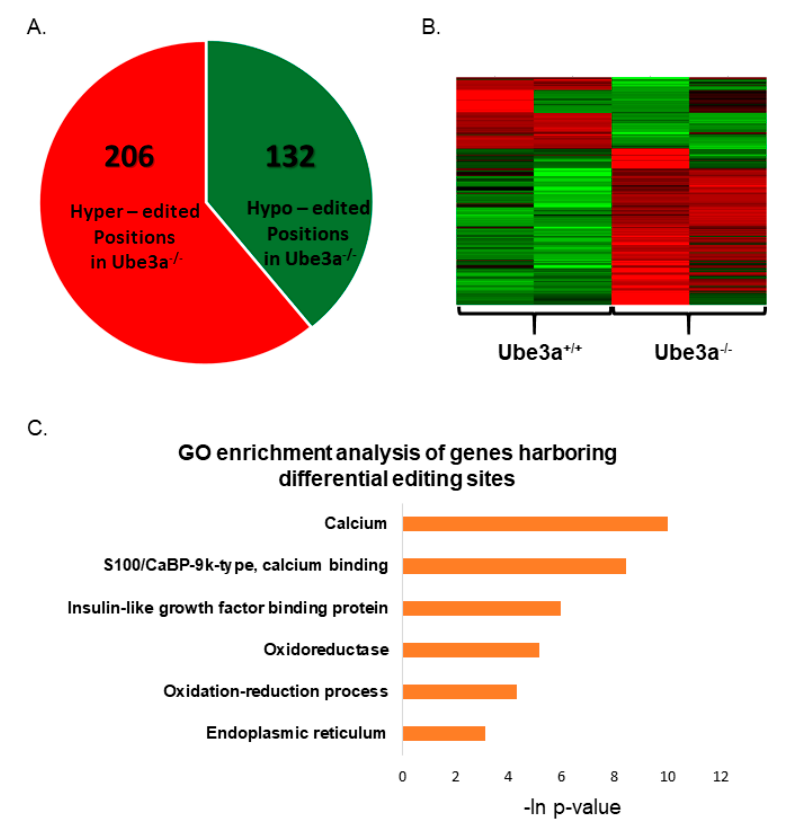
Figure 6. Di ff erential RNA editing as determined by regression-based analysis. ( A ) Di ff erentially edited sites in Ube3a − / − MEFs compared to Ube3a +/+ MEFs. We identified 206 hyper-edited and 132 hypo-edited sites in Ube3a − / − compared to Ube3a +/+ MEFs. ( B ) Heat map for di ff erentially edited genes in Ube3a − / − MEFs. Red represents sites with a higher frequency of editing (hyper-editing), and green represents sites with a lower frequency of editing (hypo-editing) in Ube3a − / − compared to Ube3a +/+ MEFs. ( C ) Enrichment analysis of di ff erentially edited genes. Topmost significantly enriched biological processes of di ff erentially edited genes in Ube3a − / − compared to Ube3a +/+ MEFs as analyzed by DAVID.